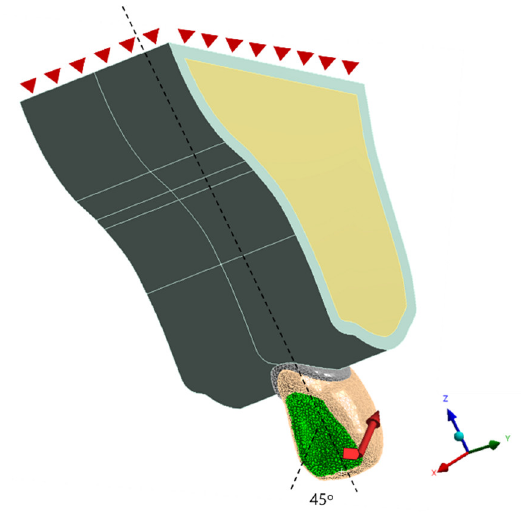
Figure 4. Boundary conditions and applied load. The red triangles on the top surface of the maxillary bone indicates a fixed boundary condition. The selected geometry surface of the palatal side of crown where 100 N load is applied is marked as green.